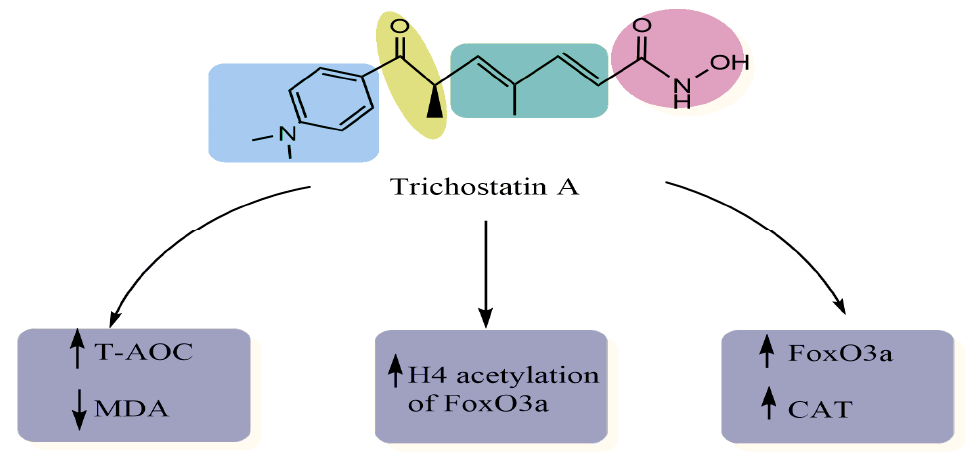
Figure 2. Antioxidant actions of TSA. Table 1. Antioxidant effects of TSA.